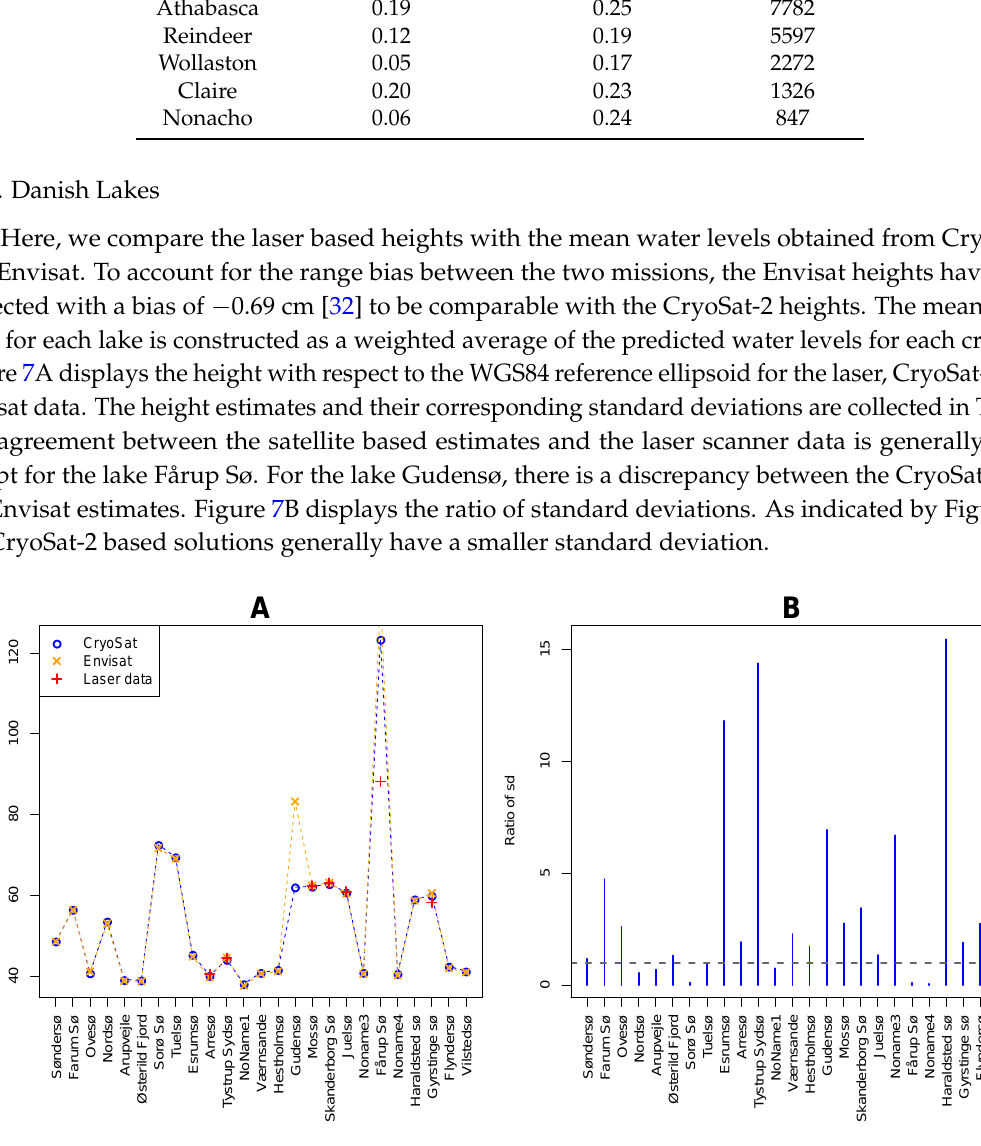
Figure 7. ( A ) the WGS84 elevations for the Danish lakes based on laser scanner data, CryoSat-2 and Envisat; ( B ) the ratio [Envisat/CryoSat-2] of the standard deviation of the estimated mean water level. Table 2. Heights in meter above WGS84 for selected Danish